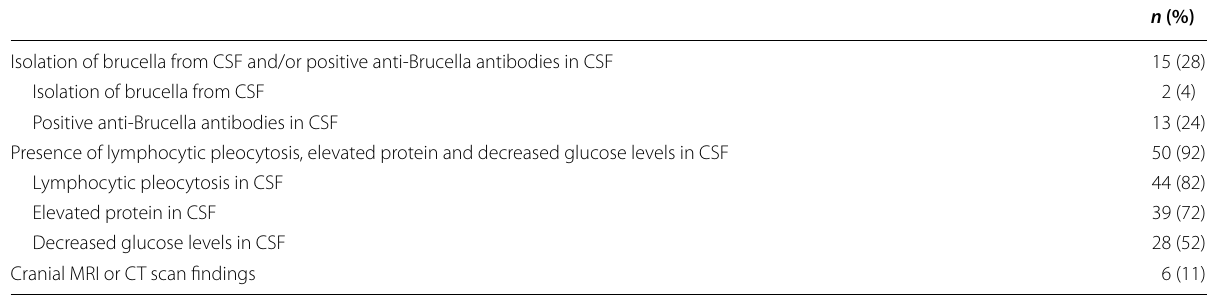
CSF: cerebrospinal fluid; MRI: magnetic resonance imaging; CT: computed tomography